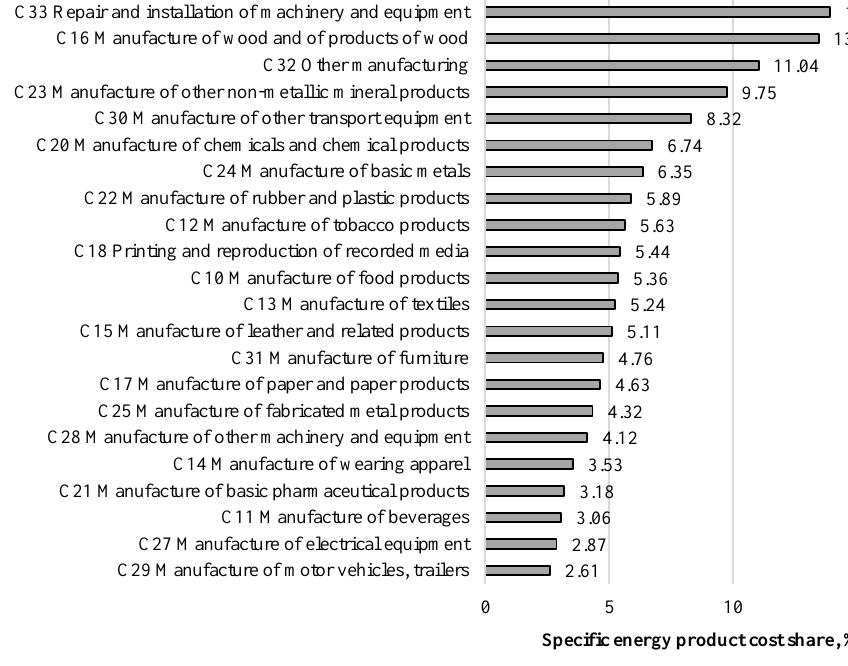
Fig. 2. Energy costs attributed to total value of production